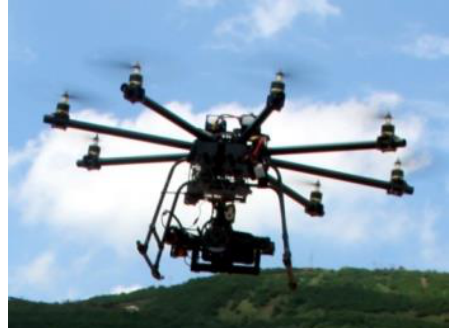
Fig.1. UAV platform